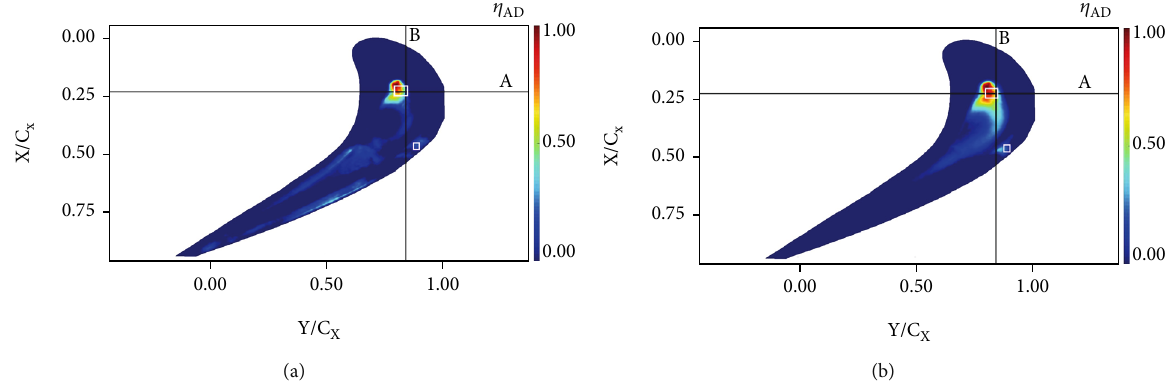
Figure 6: Locations A and B as well as regions for area averaging presented with respect to adiabatic fi lm cooling e ff ectiveness distribution. (a) Dataset 10, 0.8mm tip gap, BR = 1 : 51 . (b) Dataset 4, 1.4mm tip gap, BR = 1 : 58